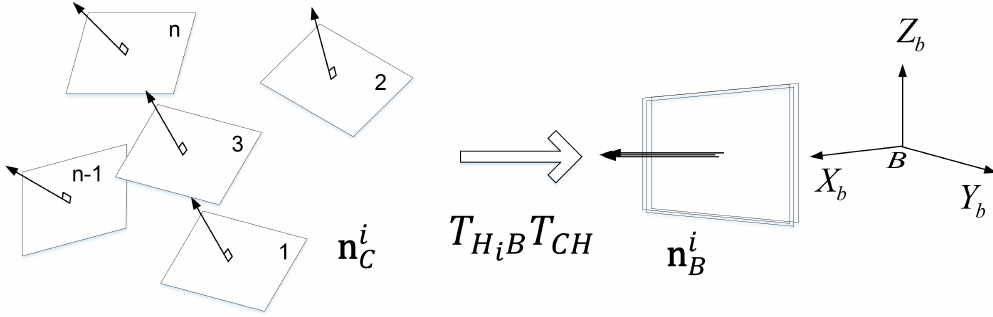
Figure 4. Proposed method: Transformation of each surface normal vector from camera coordinate system to robot base coordinate system.